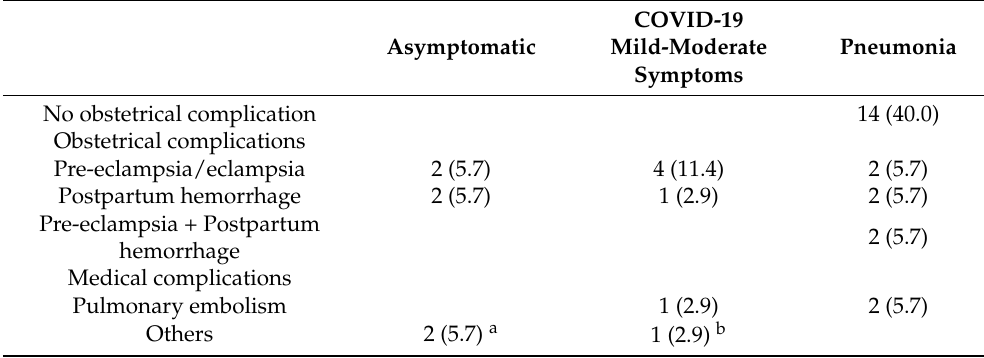
Table 3. Main causes of ICU